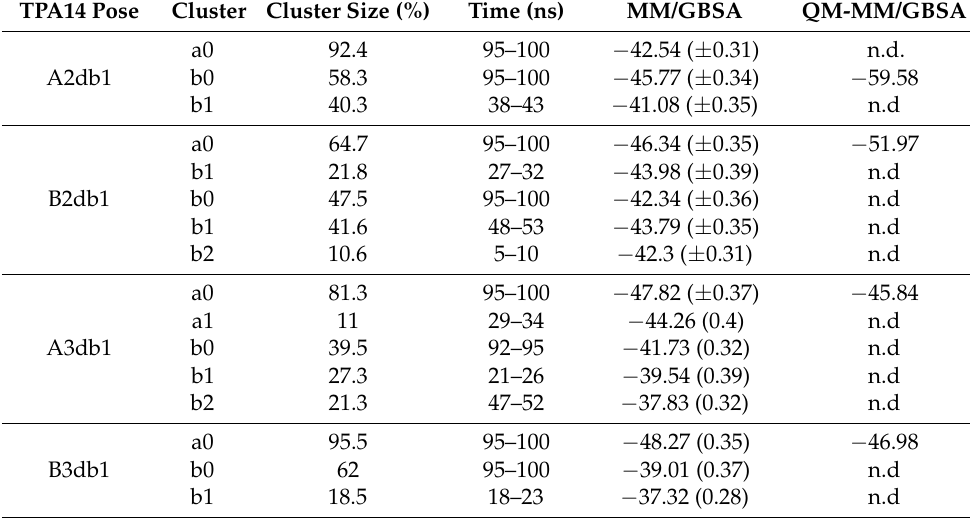
Table 4. MD simulation of TPA14 in m FAAH: cluster analysis and free-energy estimation. Data are reported for best clusters in the monomers A (a) and B (b). Time represents the time interval (in ns) used for MMGBSA and QM-MM/GBSA free-energy calculations. Free energies are in kcal/mol. TPA14